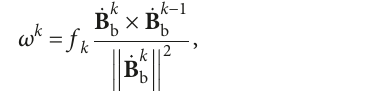
within a short interval of time. b